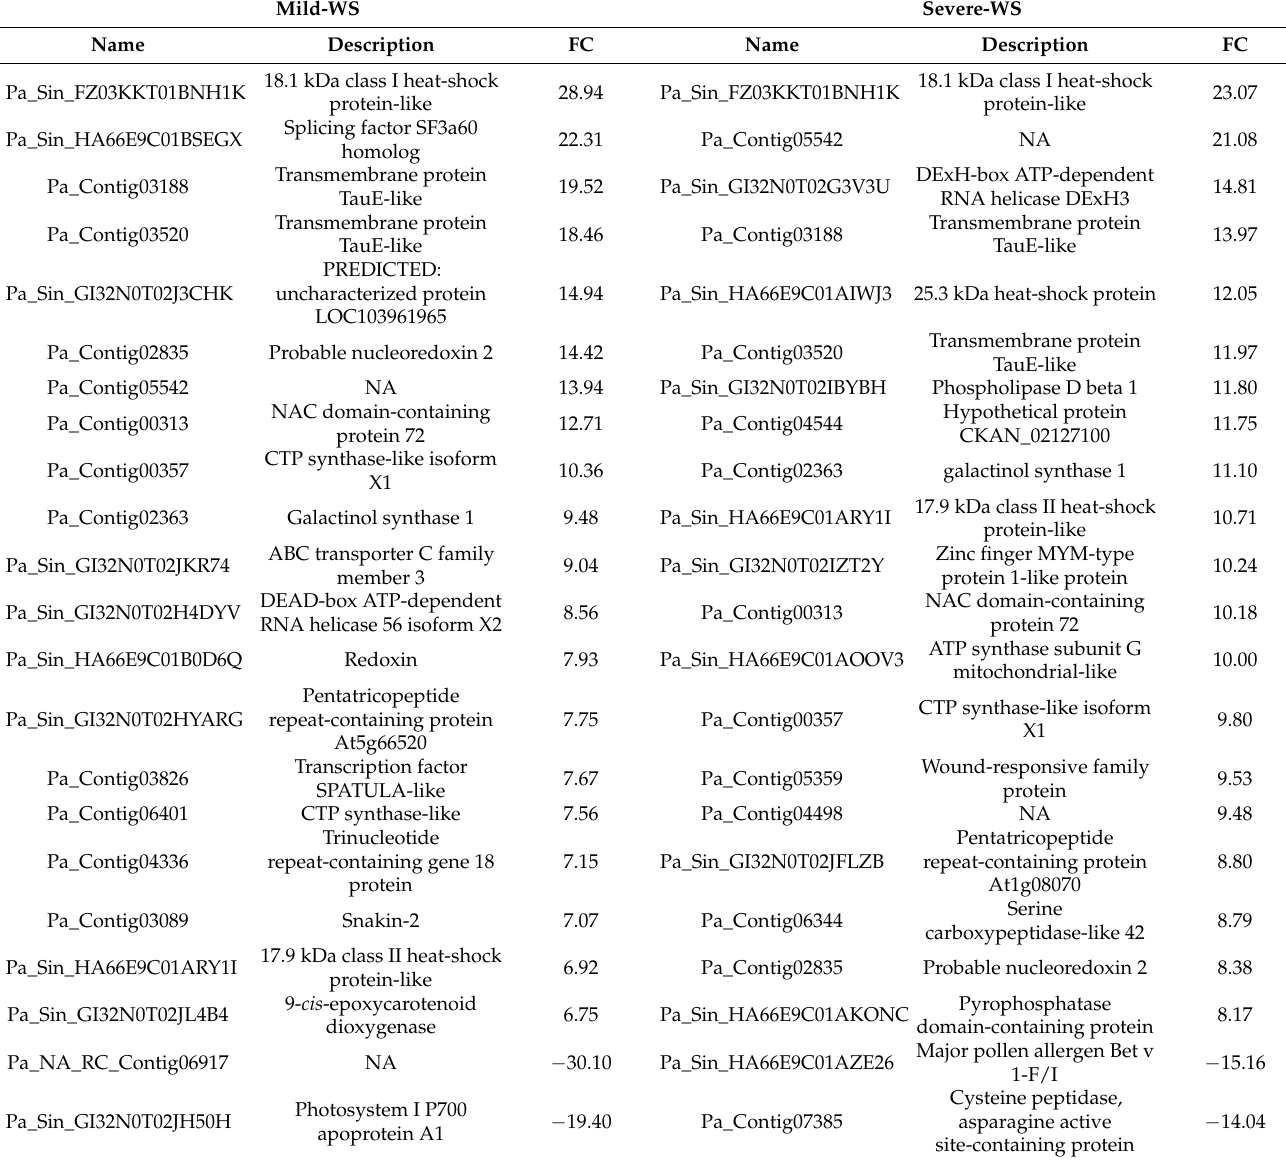
Table 3. Top 20 induced and top 20 repressed differentially expressed genes (DEGs) from ‘Dusa’ avocado rootstock subjected to two different levels of water stress: mild-WS (50% of Fc) and severe-WS (25% of Fc) (NA, nonannotated; FC, fold change). Mild-WS